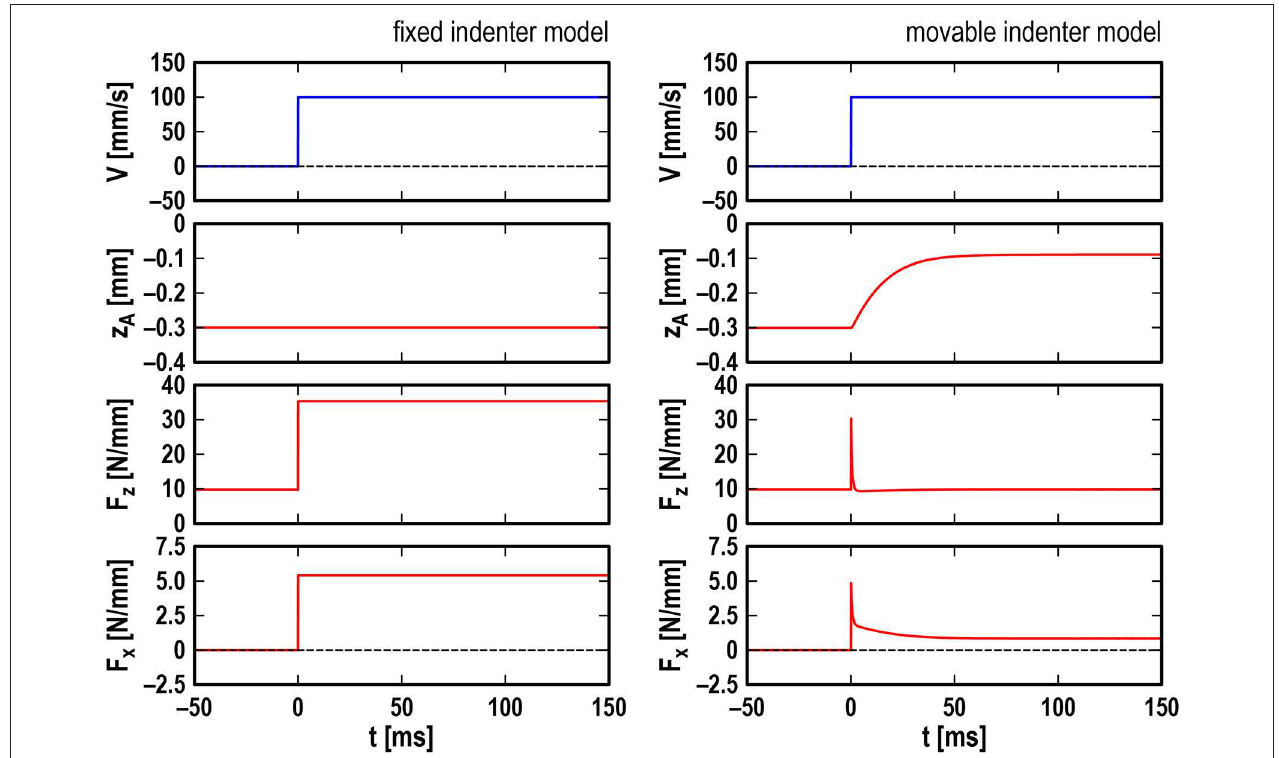
FIGURE 3 | Numerical results for fixed indenter model (Left) and movable indenter model (Right) : temporal changes in drive velocity V (top row), indenter position z A (second row), total vertical force F z (third row), and total horizontal force F x (bottom row) under standard conditions (see Table 1 for parameter values).